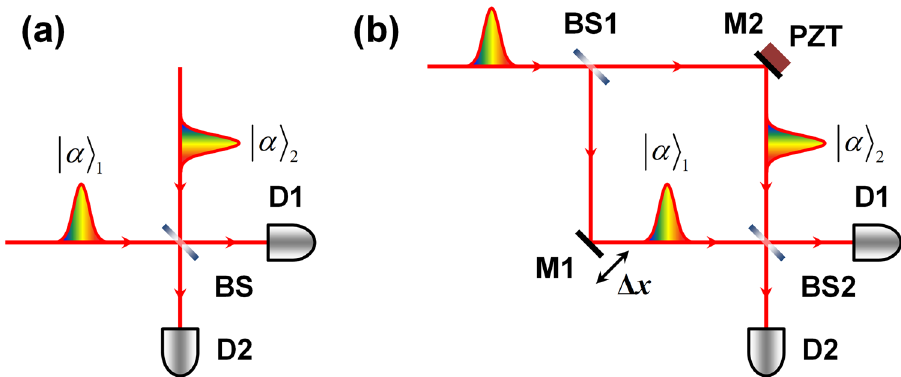
Figure 1. Two types of experimental schemes for realizing the two-photon interference of weak coherent pulses. The two photons contributing to the interference originate from ( a ) two independent sources or ( b ) a common source. BS, beam splitter; M, mirror; PZT, piezoelectric transducer; D, single-photon